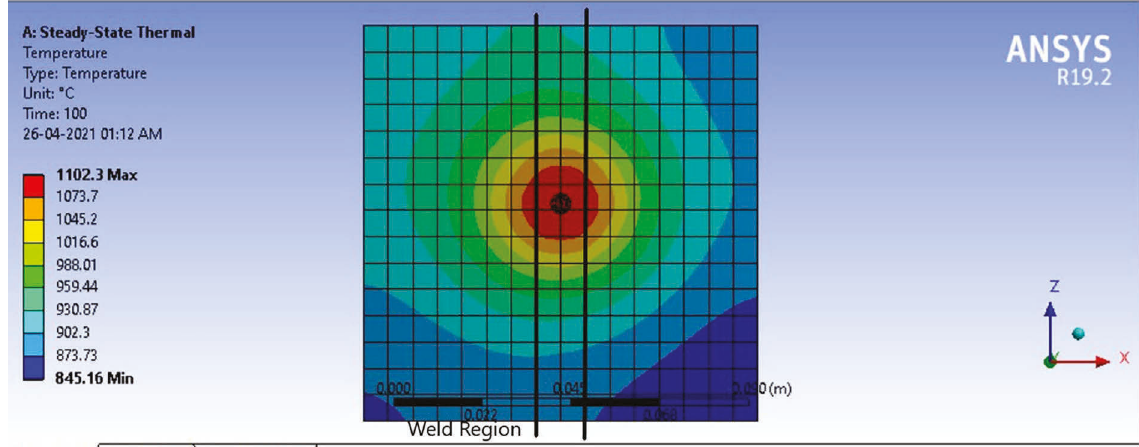
Figure 14: Temperature distribution of conventional flame welding when pin temperature is set at 1100 °